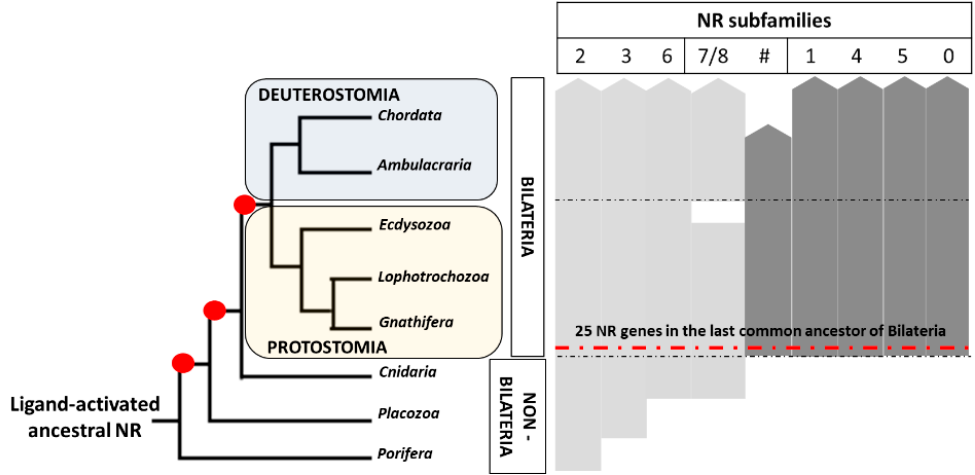
Figure 2. Evolution of the nuclear receptor (NR) superfamily. Subfamily origin and taxonomic distribution in metazoans. Animal phylogeny is based on Laumer et al. (2019) [28]. Subfamily diversification is based on data reported in the text [17–24,27]. Classification of NR subfamilies is as defined in Table 1. Red dots indicate events of subfamily diversification. The dotted red line, on the right, marks the NR expansion event at the base of bilaterians. Black thin dotted lines, on the right, indicate the separation between different animal clades (non-Bilateria/Bilateria and Protostomia/Deuterostomia). Grey bars, on the right, indicate the origin and conservation of NR subfamilies in metazoans. Light grey bars indicate NR subfamilies that were already present before the origin of bilaterians. Dark grey bars highlight bilaterian-specific NR subfamilies.